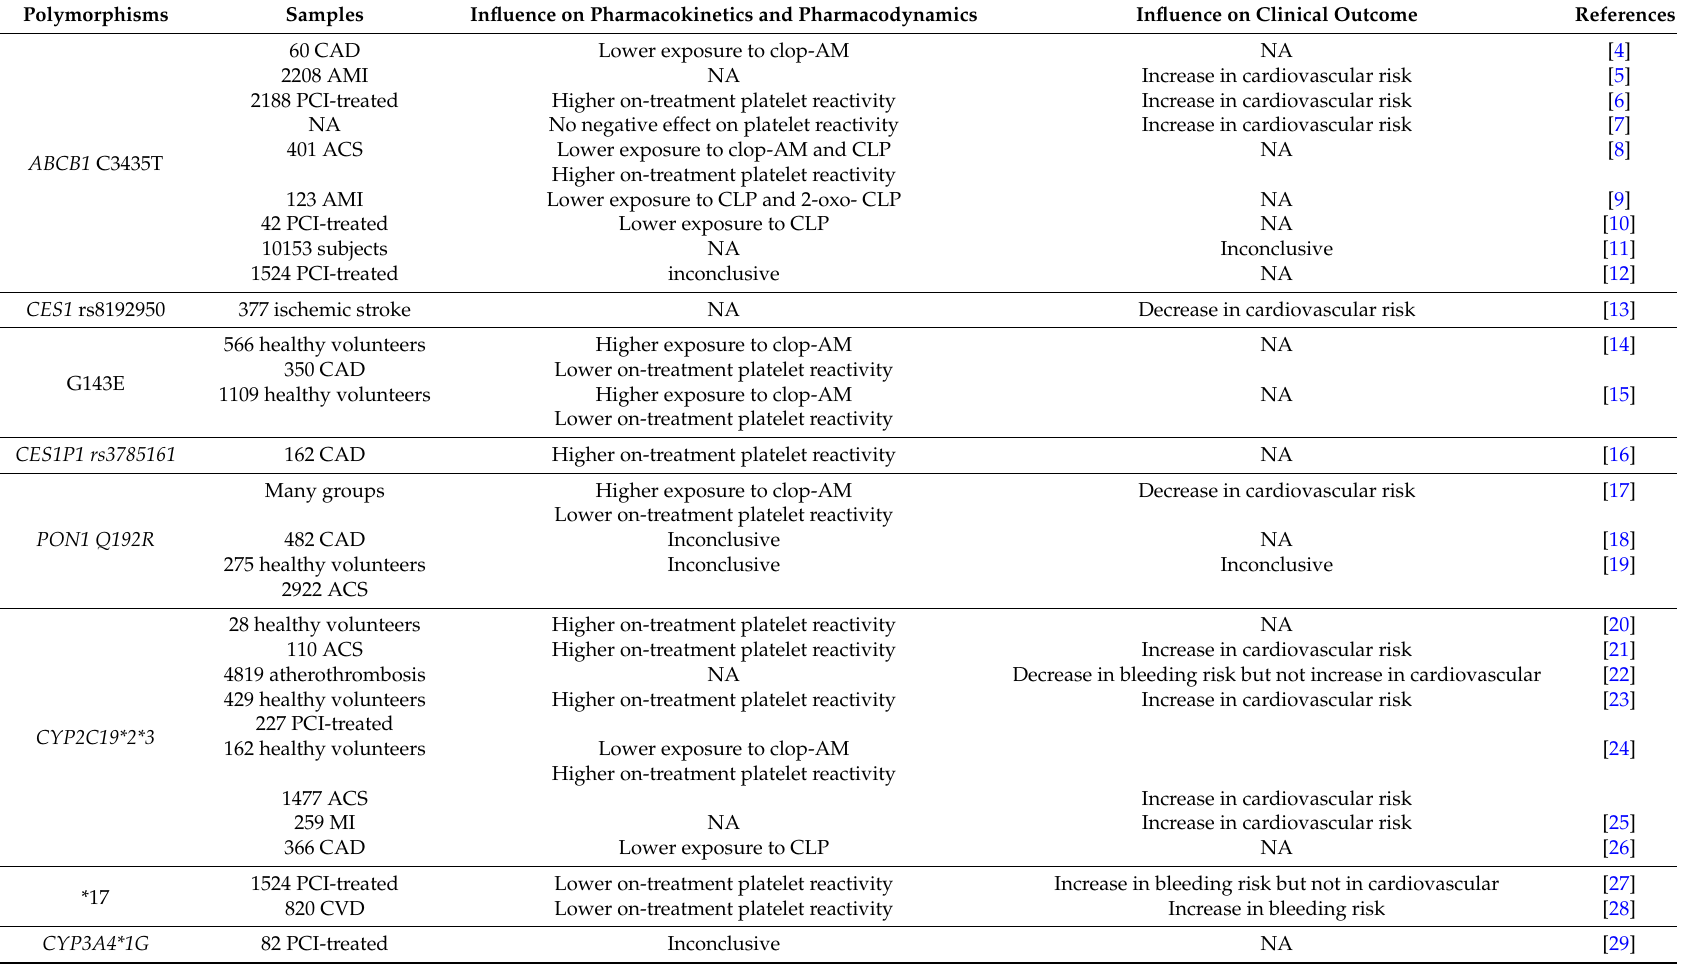
Table 1. Genetic polymorphisms observed to be associated with clopidogrel